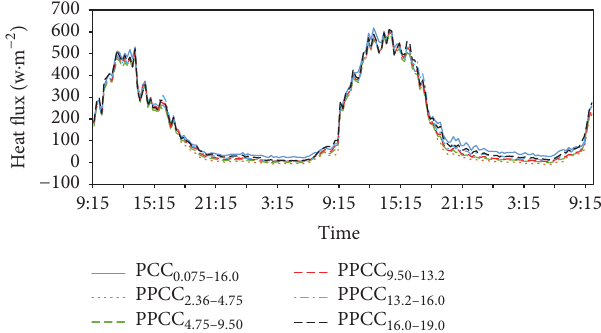
above PPCC is generally lower than that above PCC after the specimens are covered by the